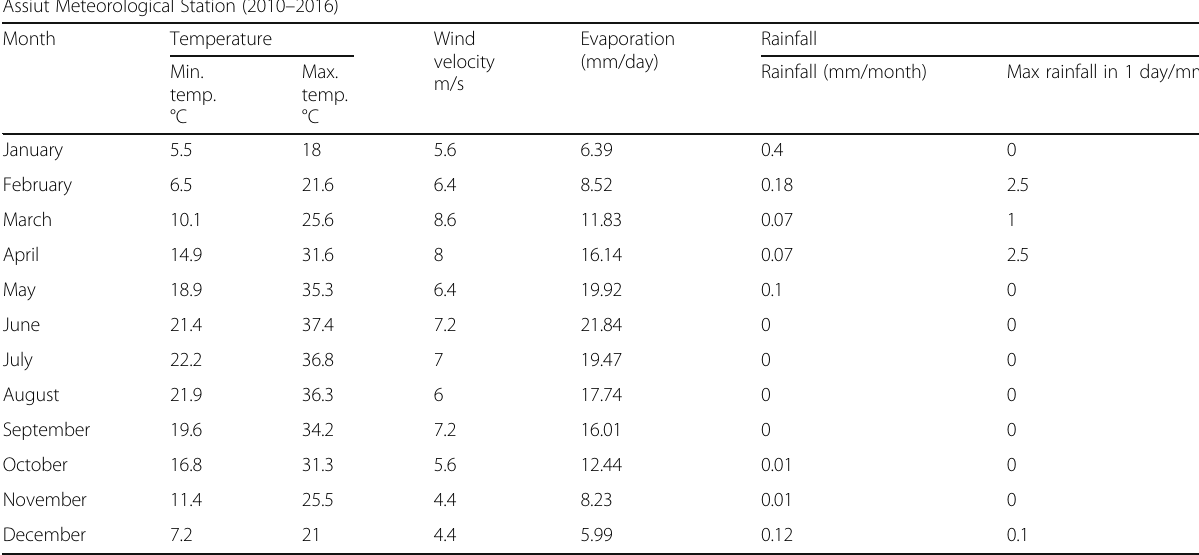
Table 1 Some climatic data averages (Assiut Meteorological Station. 2010 – 2017) Assiut Meteorological Station (2010 –